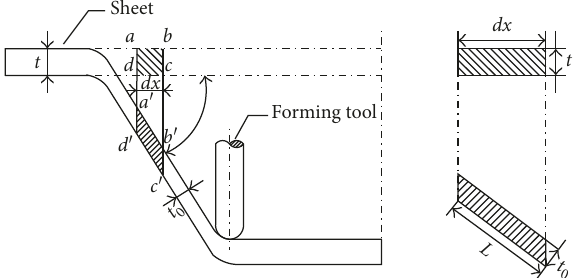
Figure 1: Illustration of the shear deformation in the SPIF